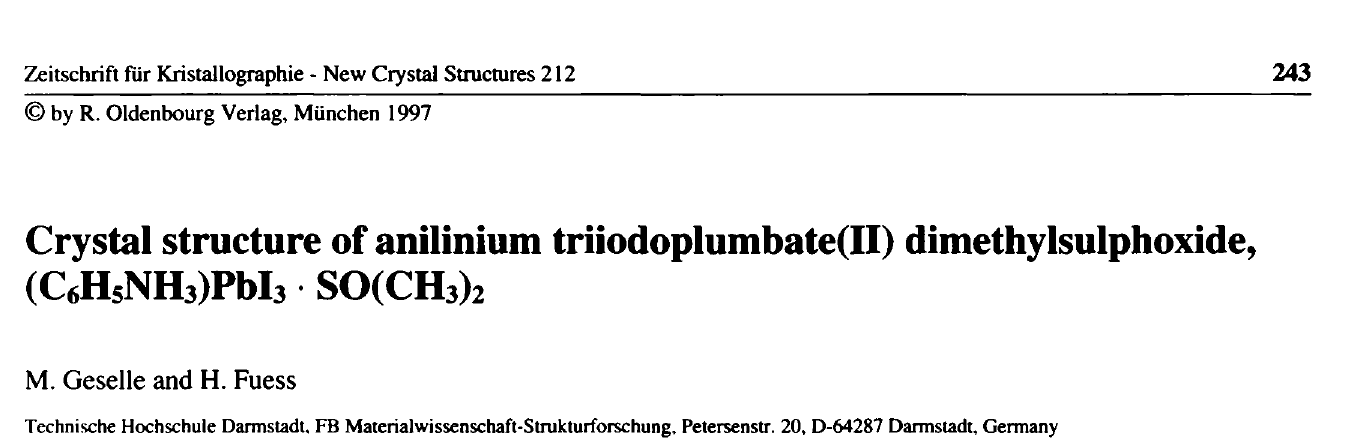
Table 1. Parameters used for the X-ray data collection Crystal: